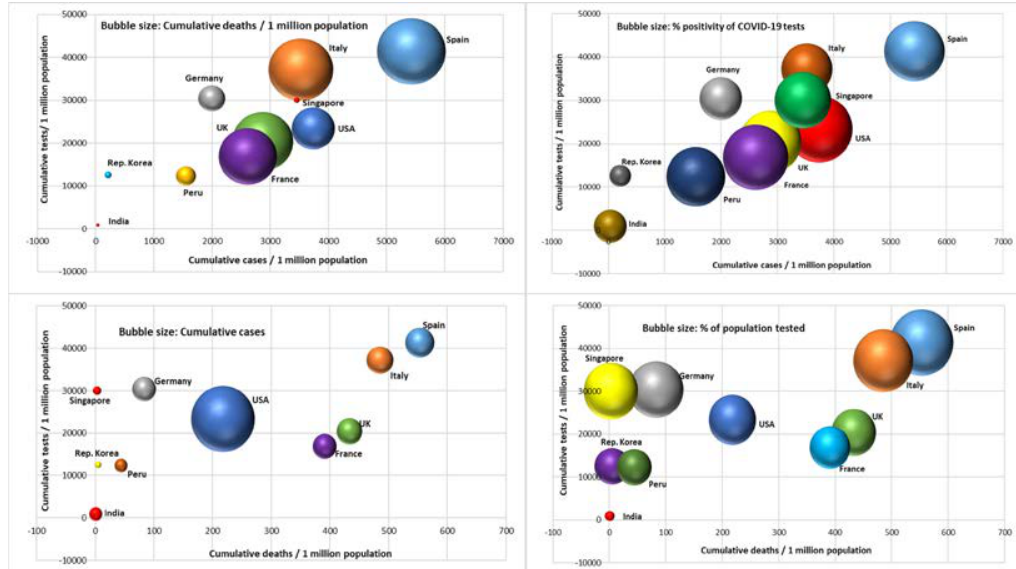
Fig. 5. Cumulative cases, cumulative tests, cumulative deaths per million populations with % positivity of tests and % of population tested in different